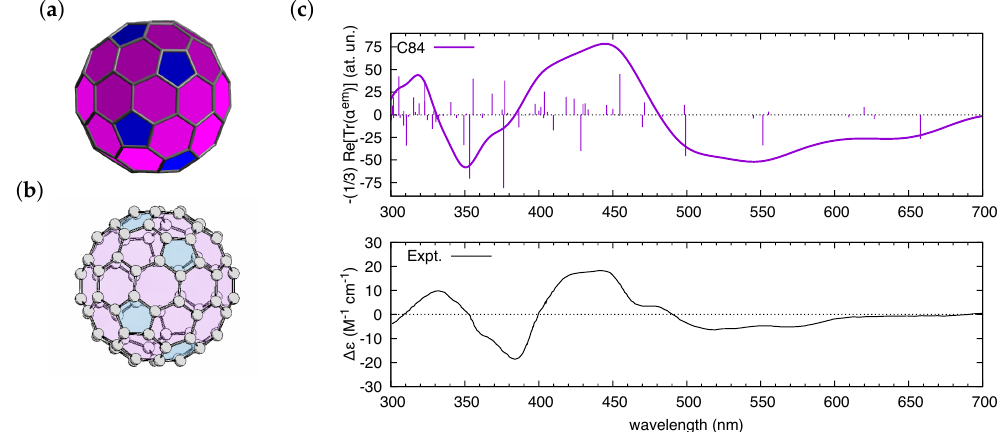
Figure 5. ( a ) The optimized structure of C 84 used to compute the electric dipole–magnetic dipole polarizability α em reported in the top part of ( c ); and ( b ) the (f A )- D 2 -C 84 configuration of C 84 which was assigned in [69] to the experimental CD spectrum represented in the bottom part of ( c ). The color scheme of ( a , b ) helps in distinguishing pentagons from hexagons in the fullerene. The experimental CD spectrum is taken from Ref. [69]. To simulate α em ( − ω , ω ) ( Γ = 0.35 eV), we fed polar with data from a TDDFT calculation (B3LYP/6-31G(d,p) level, 400